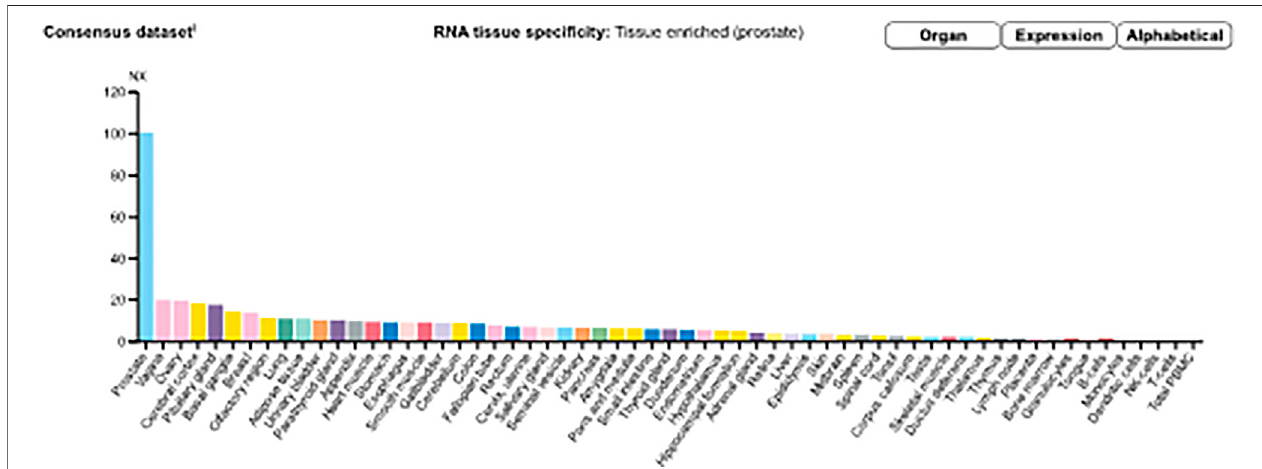
FIGURE2| Consensusnormalizedexpression(NX)levelsfor55tissuetypesandsixbloodcelltypes,createdbycombiningthedatafromthethreetranscriptomics datasets (HPA, GTEx,and FANTOM5) using theinternalnormalization pipeline. (Source: https://www.proteinatlas.org/ENSG00000157214-STEAP2/tissue).The graph maintains the initial observation that prostate tissue contains signi fi cantly high amounts of STEAP2 that any other body tissue of the 55